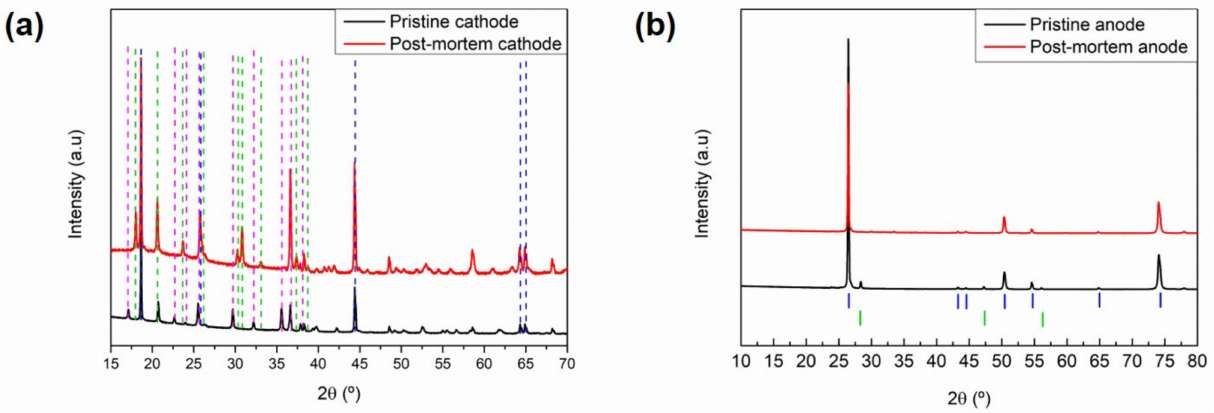
Figure 5. X-ray diffraction patterns of the pristine and aged electrodes. ( a ) Cathodes and ( b ) anodes. Blue, green, and pink dashed lines in ( a ) are ascribed to diffraction features of NMC532, LFP, and FePO 4 , respectively. Blue and green markers in ( b ) are ascribed to graphite and silicon, respectively.